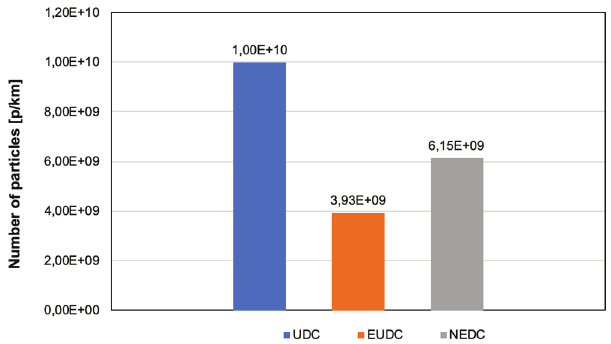
Fig. 6. Particle matters in NEDC and its phases